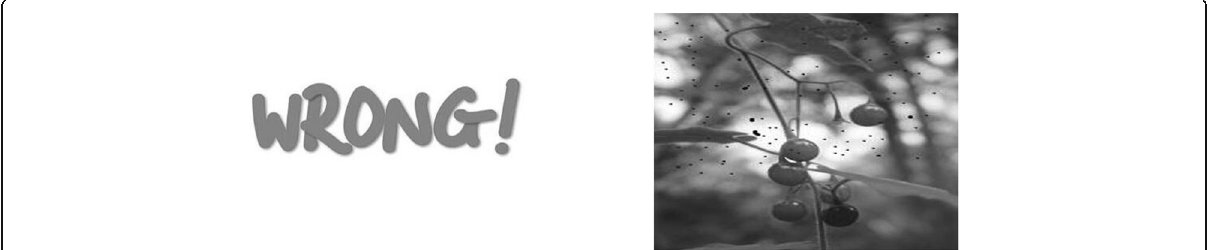
Fig. 13 Attacked with salt and pepper noise and extracted hidden image (Example